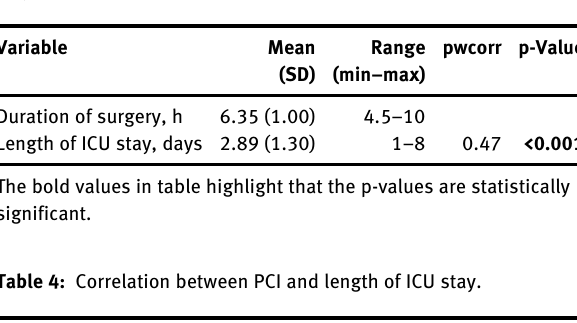
Table  : Correlation between duration of surgery and length of ICU stay.